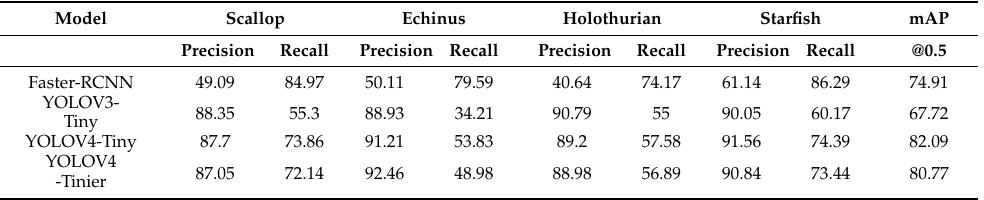
Table 4. Comparison of the detection accuracy of different